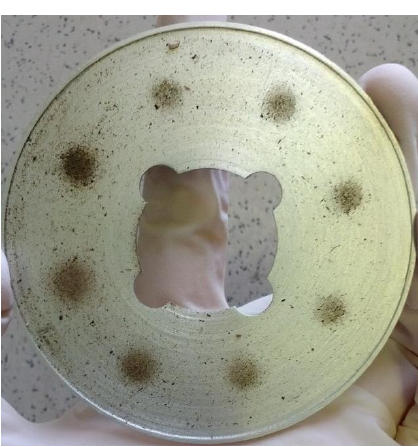
Figure 5. PM 10 pre-impactor plate from the CEM inlet (Line A, Fig. 4) during a routine cleaning after a high wind event.